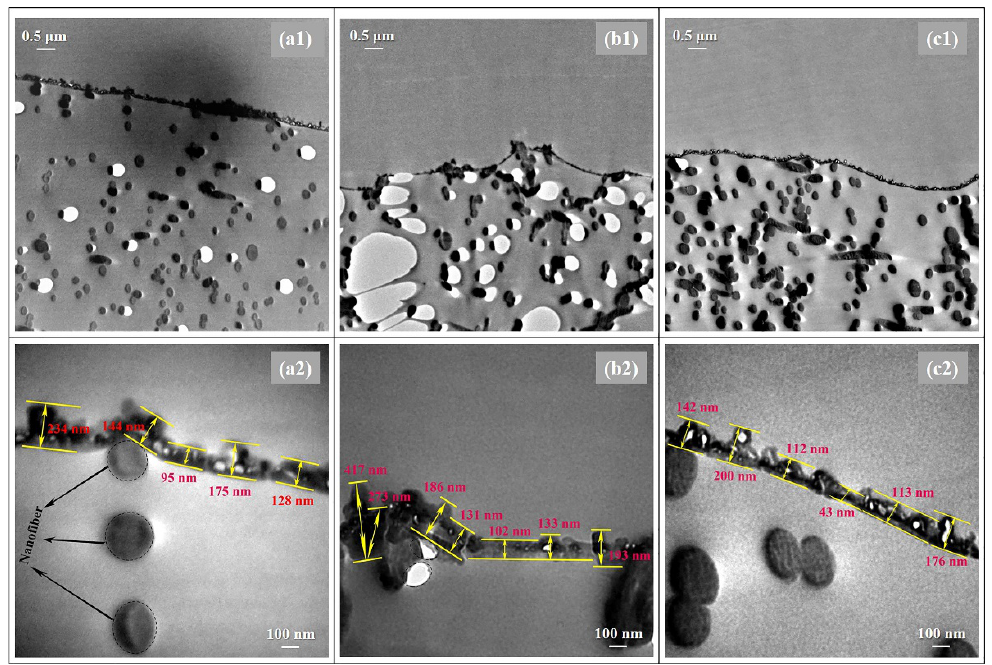
Figure 4. TEM images of the cross-section morphologies of the nanofiber-supported TFC FO membranes prepared via different heat-curing methods: ( a1 , a2 ) n-TFC; ( b1 , b2 ) o-TFC; ( c1 , c2 ) w-TFC.